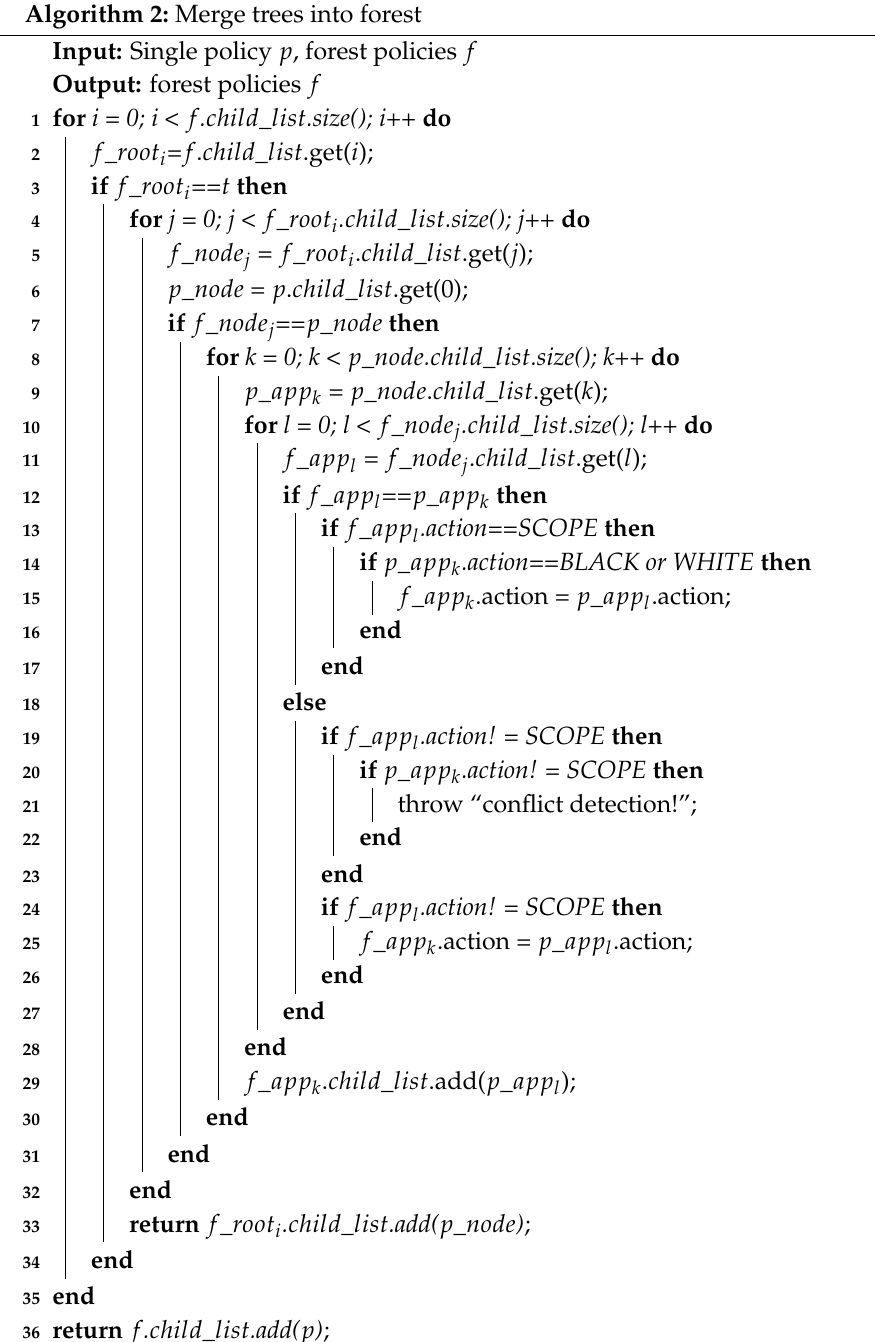
Algorithm 2: Merge trees into